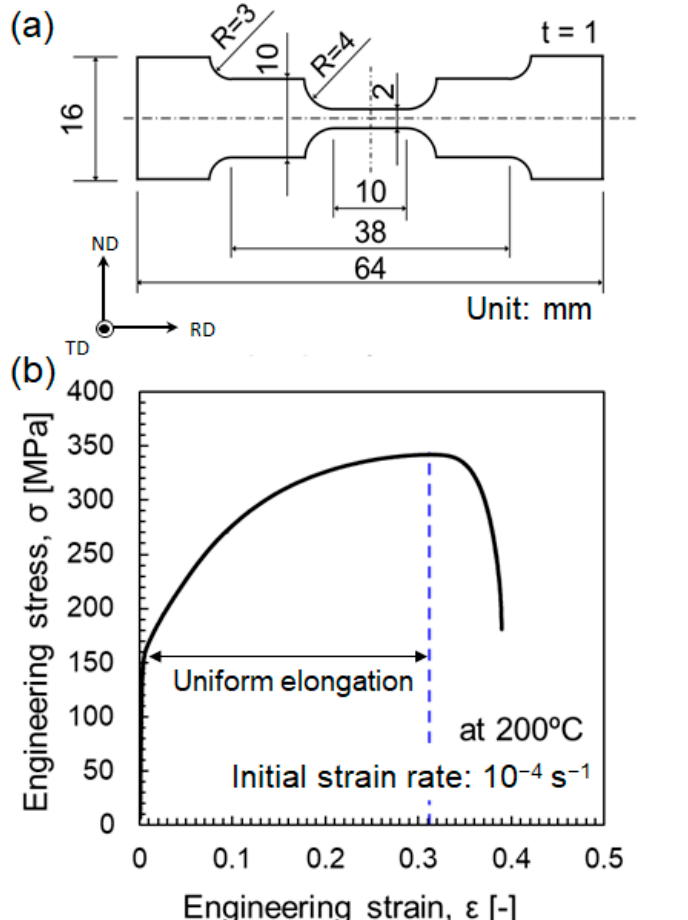
Figure 3. ( a ) Tensile specimen geometry and ( b ) engineering stress–strain curve of the specimen.